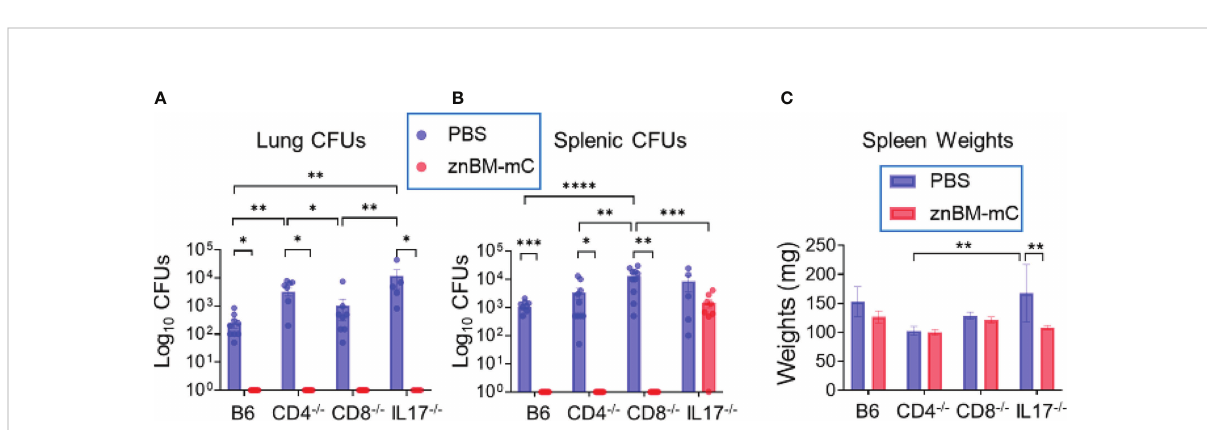
FIGURE 10 Mucosal vaccination with znBM-mC protects CD8 − / − , CD4 − / − , and IL17 − / − mice from pulmonary challenge with wt B. melitensis 16M. Groups of C57BL/6 (B6), CD4 − / − , CD8 − / − , and IL-17 − / − mice were either dosed with sPBS or vaccinated with znBM-mC as previously described. On day 56, all mice were subjected to a pulmonary challenge with wt B. melitensis 16M as previously described. Two weeks after challenge, lungs and spleens were harvested to measure the extent of brucellae colonization. (A) Lung colonization in all mouse strains post-challenge with wt B. melitensis 16M of all four mouse strains vaccinated with sPBS or znBM-mC. (B) Splenic colonization in all mouse strains post-challenge with wt B. melitensis 16M. (C) Splenic weights of all sPBS-dosed or znBM-mC-vaccinated mice for the different mouse strains are depicted. Two-way analysis of variance and unpaired t-tests were used for statistical analysis: *p <0.05, **p <0.005, ***p <0.0005, and ****p <0.0001 versus the indicated group. This experiment was performed once with 10